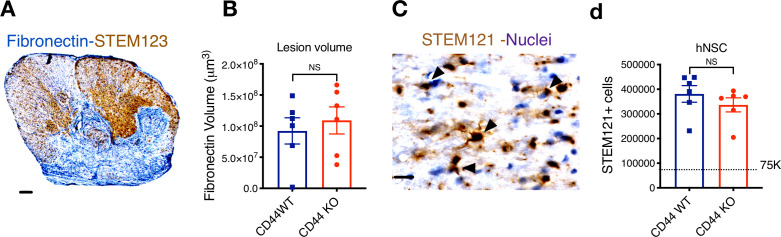
CD44 KO hNSC does not alter lesion volume or total hNSC engraftment after transplantation in the SCI acute microenvironment.Histological analysis at 16 WPT. (A) Representative image of a transverse spinal cord section immunostained for fibronectin-at the SCI epicenter (FN+, blue; scale bar = 150 μm) and STEM123+ human astrocytes (brown). Sections were counterstained for nuclei using hematoxylin (purple). (B) Quantification of host lesion volume by unbiased stereology using the Cavalieri probe in SCI mice that received WT (blue squares) or KO (red circles) hNSC. Comparisons between groups were analyzed using Student’s t-test (NS, p=0.589). (C) Immunohistochemistry for the human-specific cytoplasmic marker STEM121 (brown; scale bar = 25 μm) Sections were counterstained for nuclei using hematoxylin (purple); arrowheads indicate STEM121+ cells with hematoxylin + nuclei as quantified. (D) Quantification of the total number of hNSC by unbiased stereology using the optical fractionator probe in mice that received CD44 WT (blue squares) vs. CD44 KO (red circles) hNSC. Comparisons between groups were conducted using Student’s t-test (NS, p=0.338). Dashed line indicates the transplantation dose of 75,000 cells.